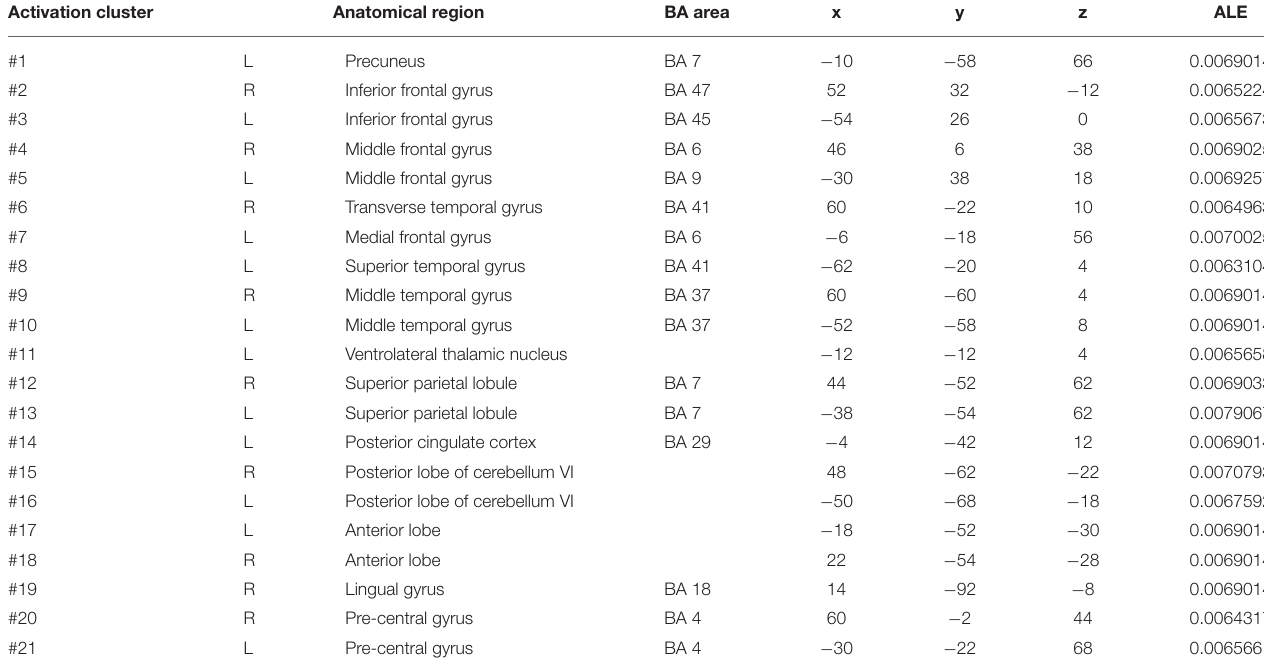
TABLE 3 | Clusters of activation in cue-priming conditions in the PD patients. Activation